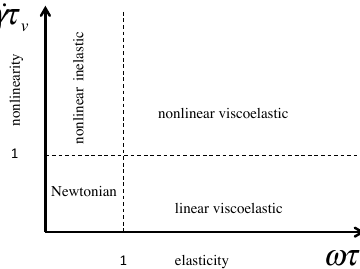
Figure 3. Diagram showing rheological flow regimes for typical macroscopic fluids. The horizontal axis represents the degree of elasticity exhibited by the flow, which is controlled by the Deborah number, the product of the characteristic frequency of the flow ω and the viscoelastic relaxation time of the fluid τ v . The vertical axis represents the degree of nonlinearity of the flow, controlled by the Weissenberg number, the product of the characteristic strain rate ˙ γ and the viscoelastic relaxation time τ v